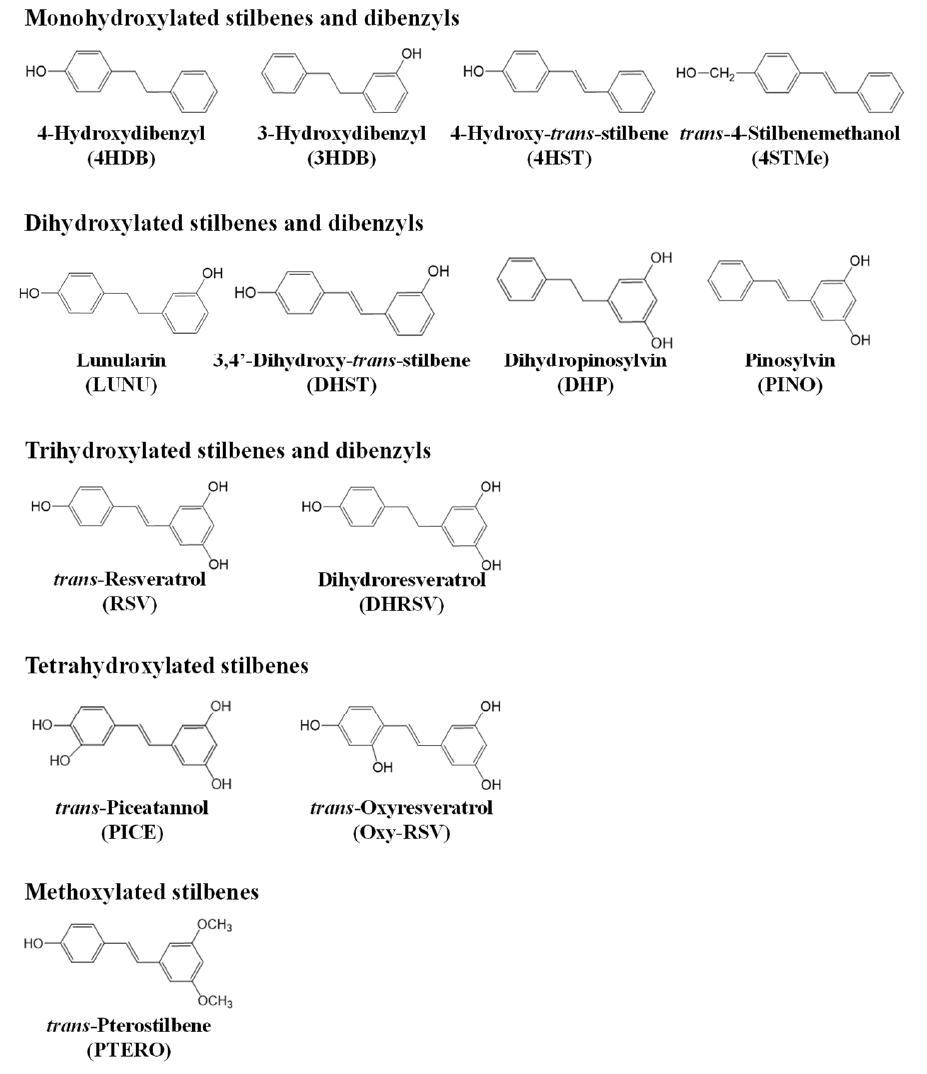
Figure 1. Structures of the stilbenes and dibenzyls that were assayed in this study. Table 1. IC 50 values a ( µ M) at 48 and 72 h in Caco-2 and HT-29 cells.